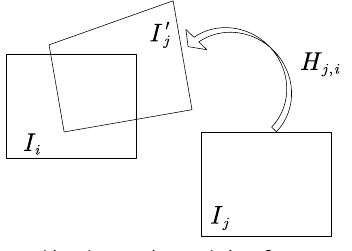
Figure 3. video image dynamic keyframes